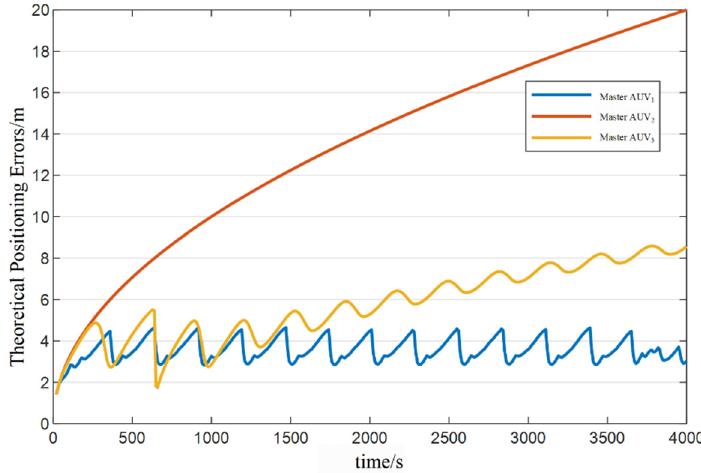
Figure 10. Theoretical positioning errors of the AUVs.